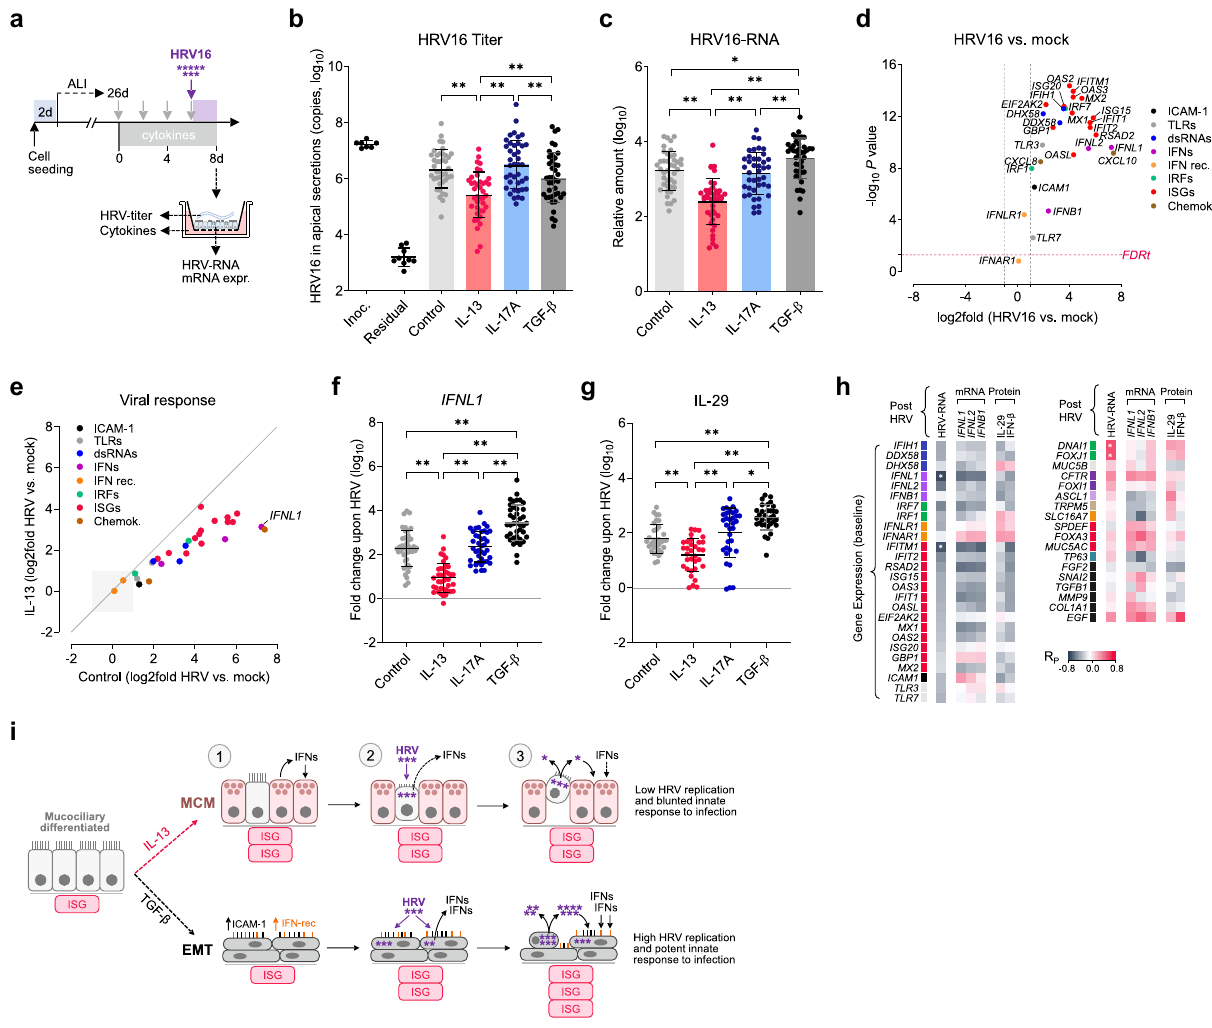
Figure 2. Reduced susceptibility to HRV16 infection in bronchial epithelium with IL-13-induced mucous cell metaplasia (MCM). ( a ) Air–liquid interface (ALI) differentiated bronchial epithelium was cultured with IL-13, IL-17A, or TGF-β (or w/o cytokines) and then infected 48 h with HRV16. ( b ) HRV16 titer in apical secretions in the indicated conditions, the inoculum (inoc.), and after wash (residual). ( c ) Expression of HRV16-RNA in cell lysates. ( d ) Relative expression of antiviral genes, including toll-like receptors (TLRs), dsRNA sensors, interferons (IFNs), and interferon-stimulated genes (ISGs) in the HRV16-infected mucociliary epithelium (control conditions) compared to mock (n = 19, 2-sided paired t-test P < 0.05, FDRt q = 0.05). ( e ) Fold differences (HRV16 vs. mock) in the expression of antiviral genes in bronchial epithelium exposed to IL-13 or in control conditions. ( f ) Fold change in the expression of IFNL1 mRNA, and ( g ) in the level of IL-29 in cell culture supernatant upon HRV16 infection in different conditions. Statistics (‘b’, ‘c’, ‘f’ and ‘g’): Bars represent means and SD (n = 40). RM 1-way ANOVA (Tukey): * P < 0.05, ** P < 0.01. ( h ) Correlation heat map (Pearson’s coefficients [R P ]; control conditions) showing the association between baseline mRNA expression of viral response ( left ) or structural ( right ) genes, and subsequent response to HRV16 (e.g., HRV-RNA and type III IFNs). n = 19, * P < 0.01. ( i ) A model of putative mechanism of HRV infection in remodeled bronchial epithelium. (1) The exposure of bronchial epithelium to IL-13 induces MCM, while stimulation with TGF-β leads to epithelial- mesenchymal transition (EMT). (2) MCM renders the epithelium less sensitive to infection, as HRV targets primarily sparsely distributed ciliated cells and does not efficiently replicate in mucous cells due to their ‘antiviral state’, while epithelium with EMT is more permissive to HRV infection. (3) The magnitude of innate inflammatory response is determined by HRV replication rate and autocrine action of type I and III